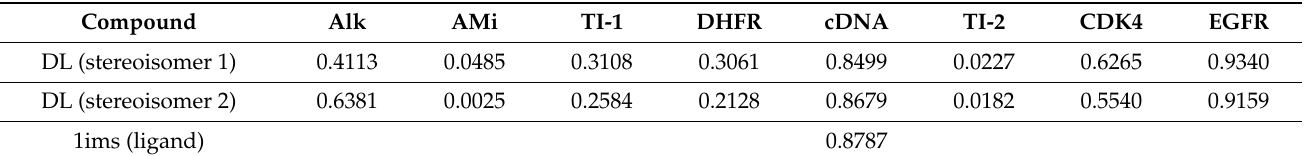
Table 8. Predicted probability of anticancer activity of DL for different mechanisms of action